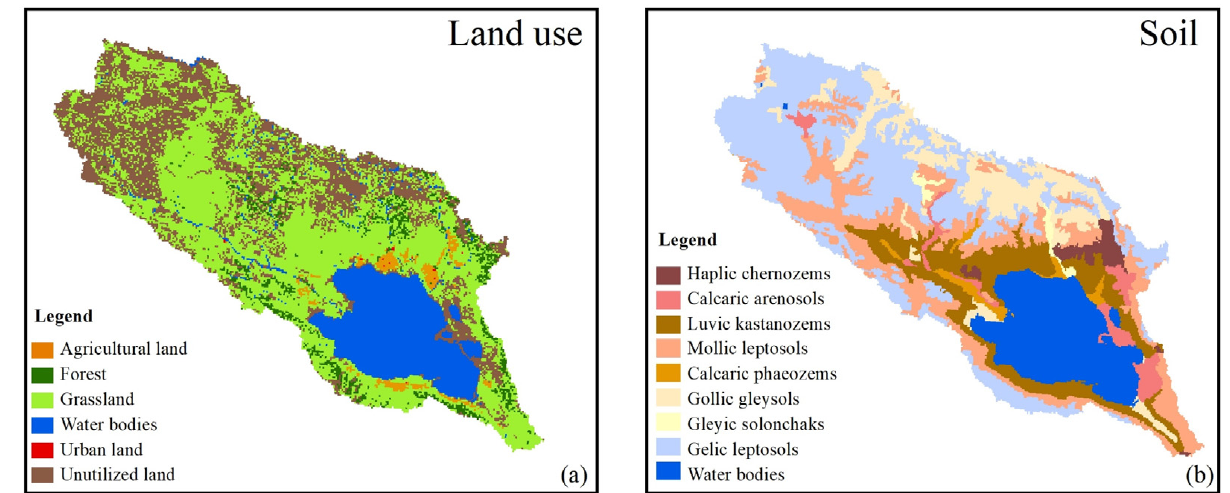
Figure 2. ( a ) Land use in the 2010s and ( b ) soil types in the study area.